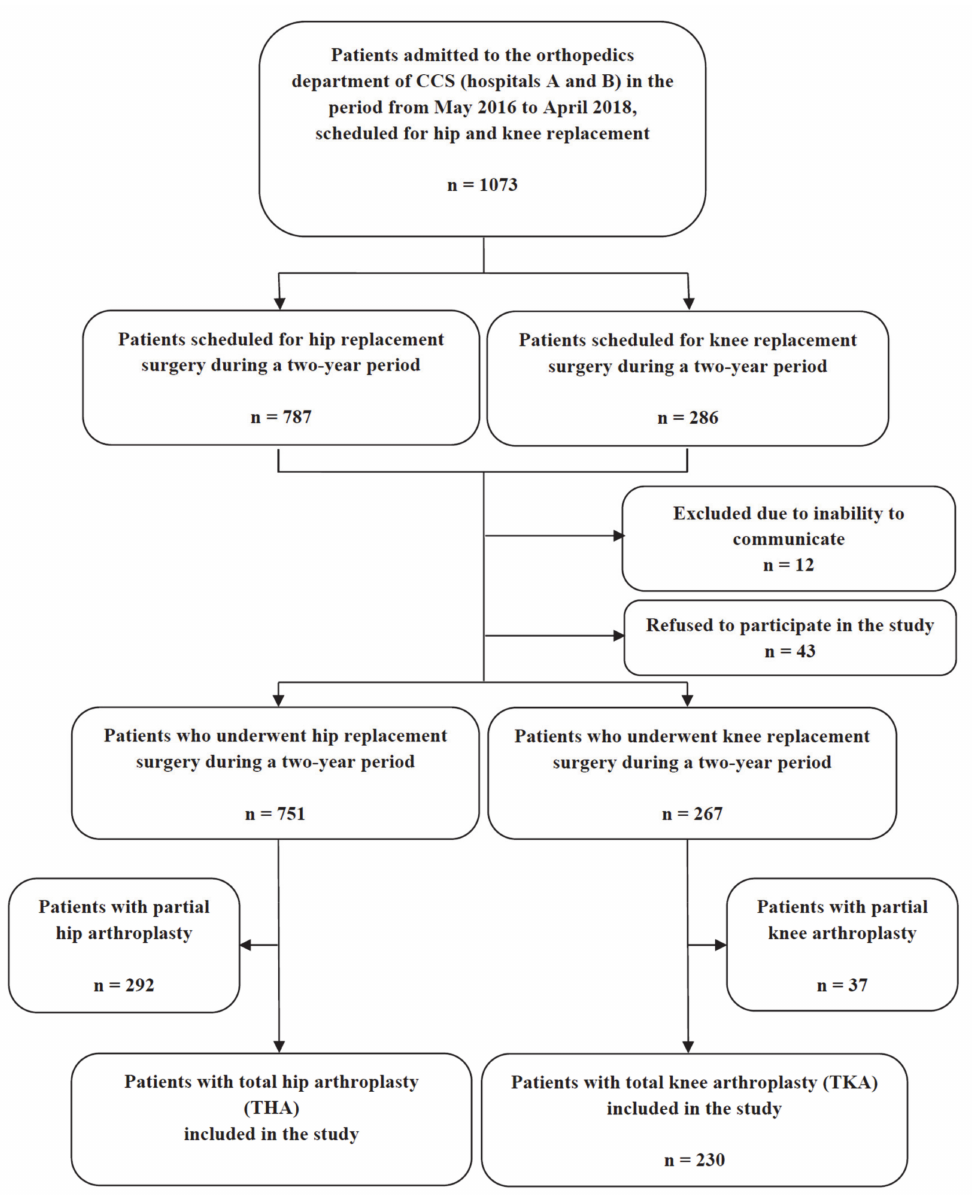
Figure 1. Flowchart of the